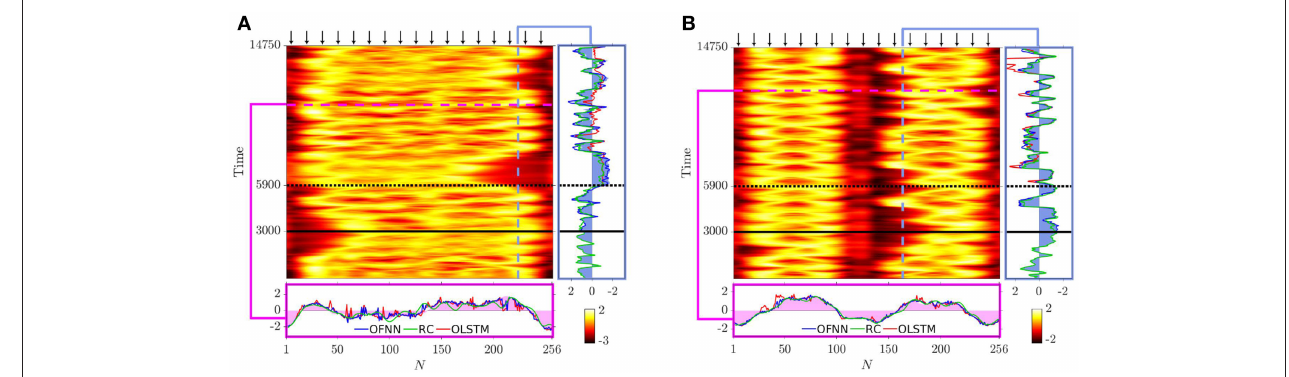
FIGURE 1 | Spatiotemporal plots of single- and double-headed chimeras and predicted time series and fluxes. (A) Spatiotemporal plot of a single-headed chimera state, generated in the 1-dimensional SQUID array of Hizanidis et al. [20] Figure 4e, depicting the evolution of the fluxes (values are color-coded), for the one-headed chimera observed in a large array of 256 coupled SQUIDs by dipole-dipole moments, which has been studied numerically for a nonlocal coupling scheme. In predicting the spatiotemporal evolution of this chimera, 17 “observers” have been placed in the positions marked by the tips of the arrows. The thick horizontal black line marks the end of the RC training time, while the dotted horizontal black line marks the end of the OLSTM (and OFNN) training time. Right, vertical inset: predicted time series for the flux of SQUID #223: shaded blue color depicts the actual (ground-truth) data, red line depicts prediction by OLSTM, green line depicts prediction by RC, blue line depicts prediction by OFNN. Bottom inset: predicted fluxes for all SQUIDs (entire metamaterial) at time step t n = 11,000: symbols are the same as in the right inset, but with pink depicting the actual (ground-truth) data. (B) same as in part (a), but for a double-headed chimera state generated in the 1-dimensional linear SQUID array of Hizanidis et al. [20] Figure 4d. Right, vertical inset: the predicted time series for the flux of SQUID #163. Bottom inset: the predicted fluxes for all SQUIDs (entire metamaterial) at time step t n =